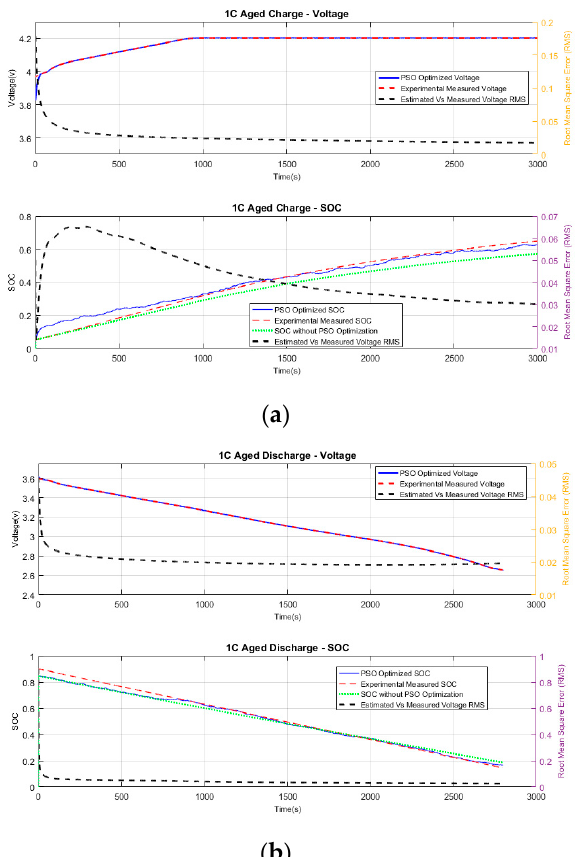
Figure 5. Aged battery experimental vs. PSO voltage: ( a ) 1C charging; ( b ) 1C discharging.